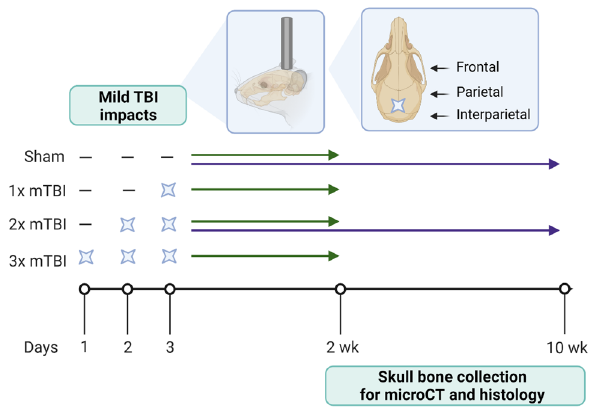
Figure 1. Schematic of study timeline. Rats received 0–3× mTBI impacts or sham procedures spaced 24 h apart. Animals were euthanized at either 2 weeks (sham, 1× mTBI, 2× mTBI and 3× mTBI groups) or 10 weeks (sham and 2× mTBI groups), with the time point referring to time following the last mTBI/sham procedure for collection of skull bones for microCT and histology. Illustrations depict the site of impact of the weight drop model on the rat skull, from a sagittal and dorsal view, respectively. Time points were chosen based upon previous findings in this model, whereby 2× mTBI animals often showed the greatest effects compared to sham controls 22,23 . Created with Biorender.com.